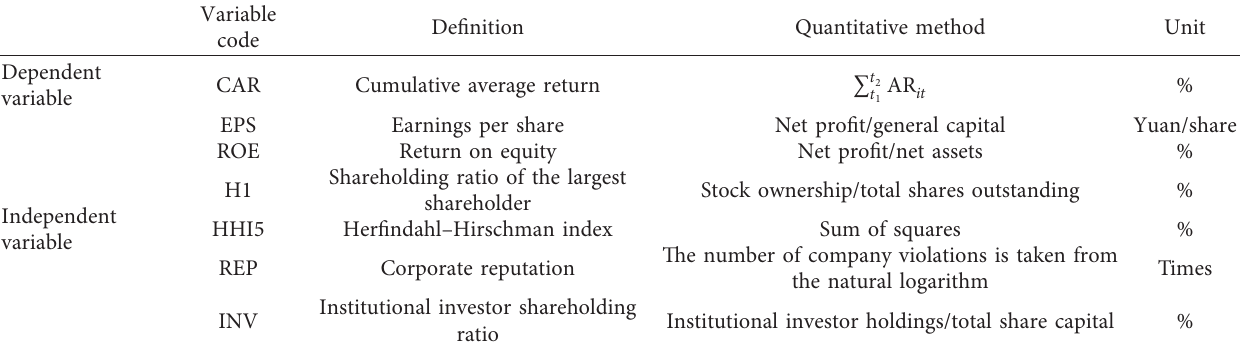
Table 1: Selection and definition of